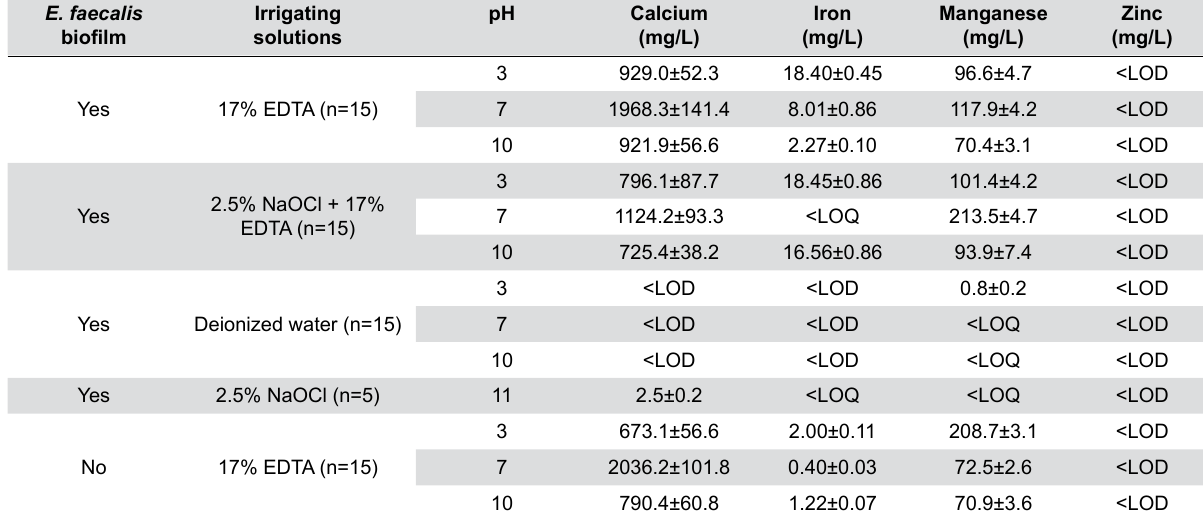
Table 1- Mean±standard deviation (SD) values of concentration of chemical elements detected after the use of chelating agents at different pH levels on E. faecalis